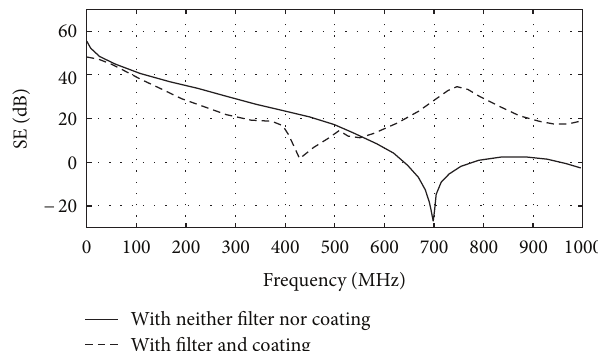
F 19: Shielding effectiveness versus frequency for an internally illuminated by a plane wave at normal incidence with a spatial �lter